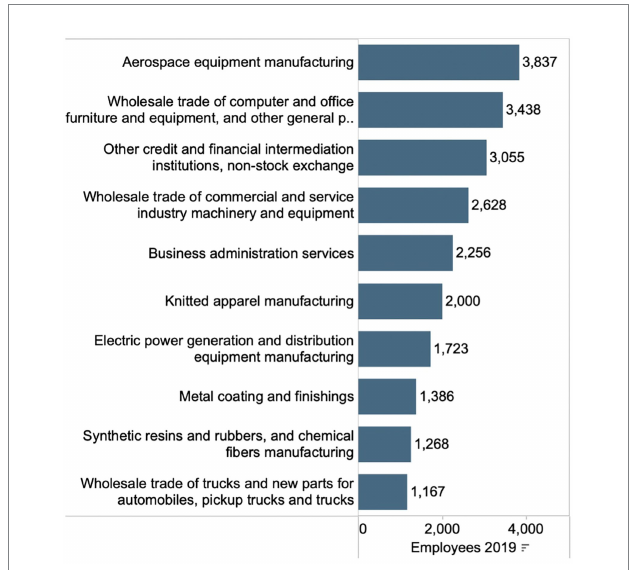
FIGURE 2 Top 10 industries that have emerged from 2004 to 2019. Own calculation based on Economic Censuses (INEGI) of 2004 and